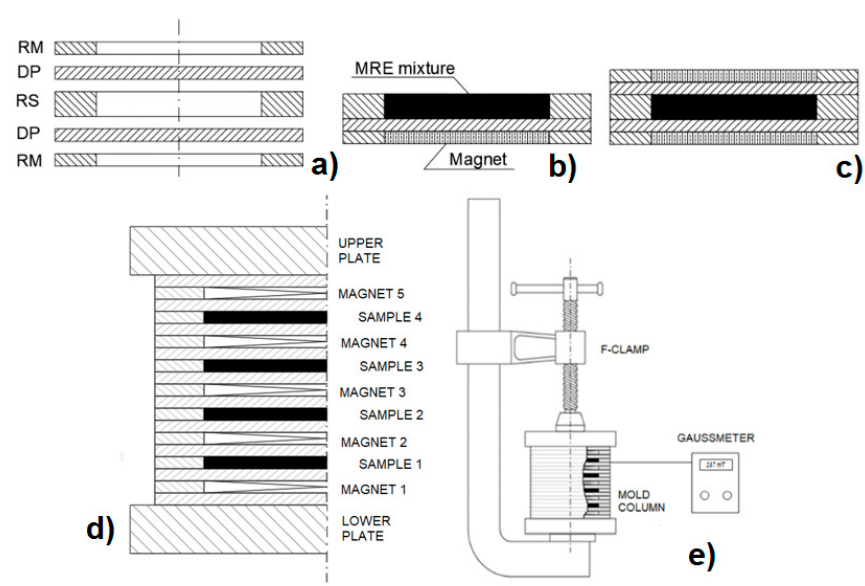
Figure 4. ( a ) Mold elements; ( b ) pouring phase; ( c ) polymerization phase; ( d ) multilayer mold; ( e ) static magnetic field measure.